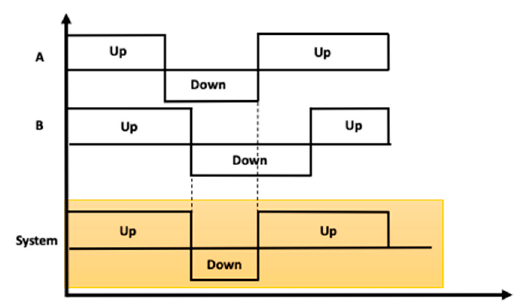
Figure 4. System availability according to different system topologies.